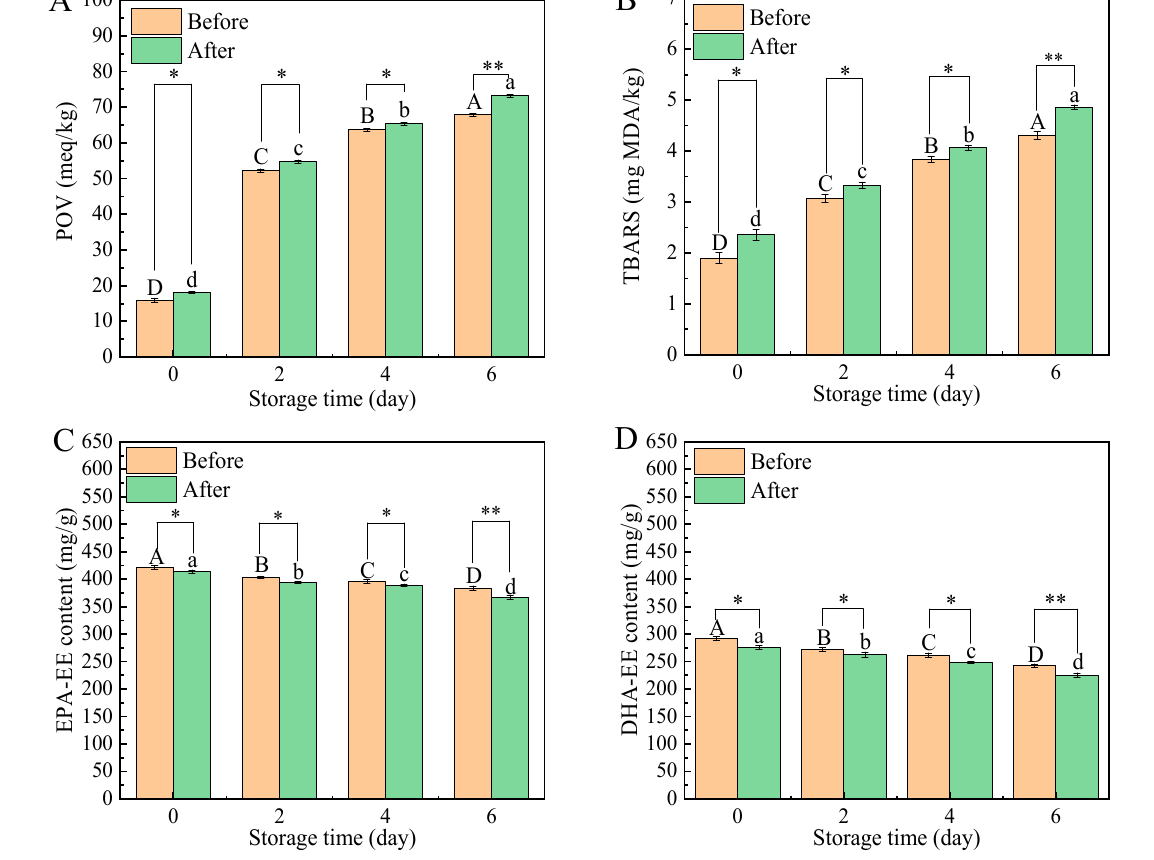
Figure 1. Effect of TPP added before or after the process of ethyl esterification on POV ( A ), TBARS ( B ), EPA-EE content ( C ) and DHA-EE content ( D ) of ethyl-esterified fish oils stored at 60 °C for different times. Values of different groups with different uppercase letters (A–D) or lowercase let- ters (a–d) are significantly different at p < 0.05; The asterisks (*) indicate the significant differences between the two groups with the same storage time at p < 0.05. The asterisks (**) indicate the signif- icant differences between the two groups with the same storage time at p < 0.01.